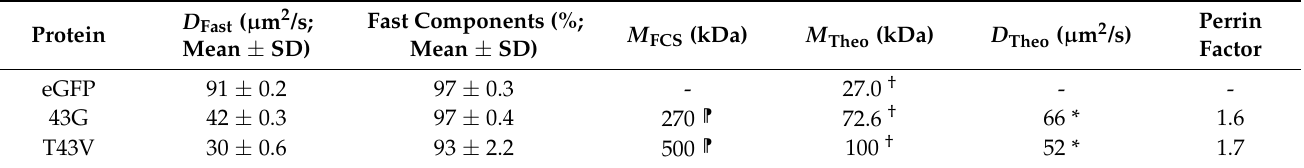
Table 1. Diffusion coefficient and calculated molecular weight of fluorescent protein-tagged wild-type TDP-43 in cell lysate using fluorescence correlation spectroscopy. D Fast ( μ m 2 Protein